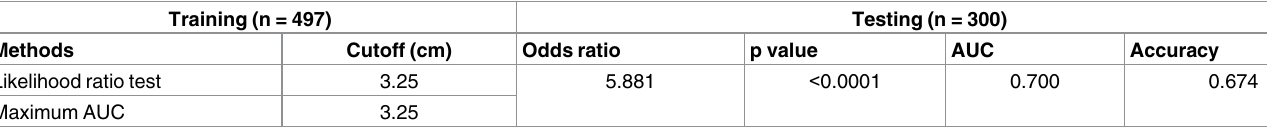
Table 3. Optimal cutoff point of tumor size against risk of lymph node metastasis. Training (n =